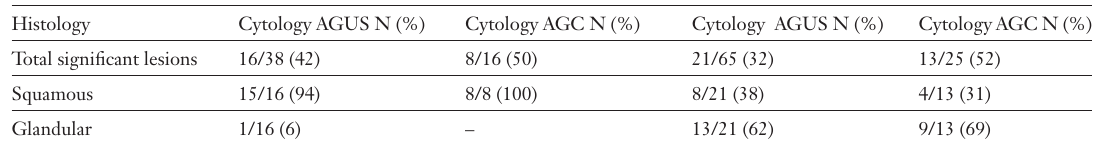
Clinically significant lesions in AGUS vs. AGC in women <40 and in women ≥40.